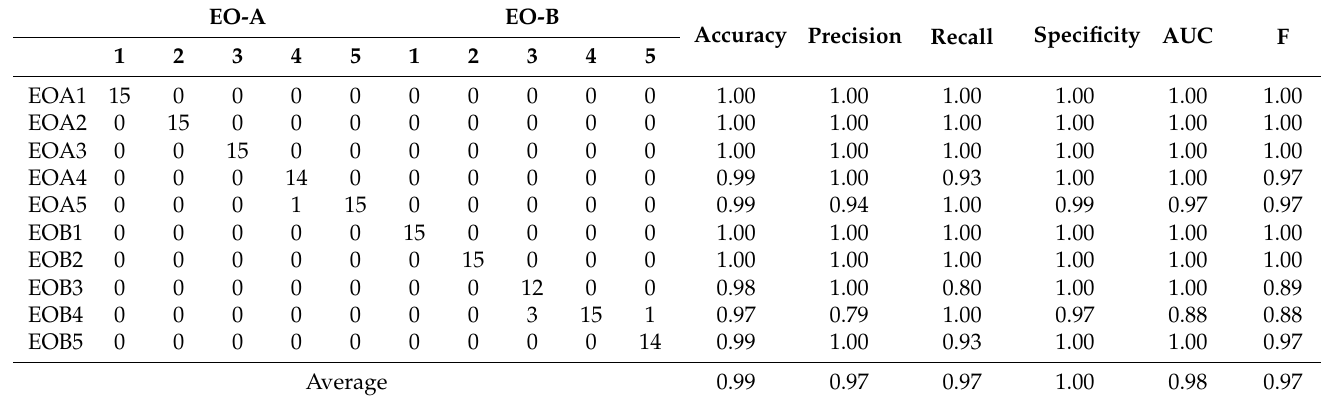
Table 6. Confusion matrix and performance parameters of ANN